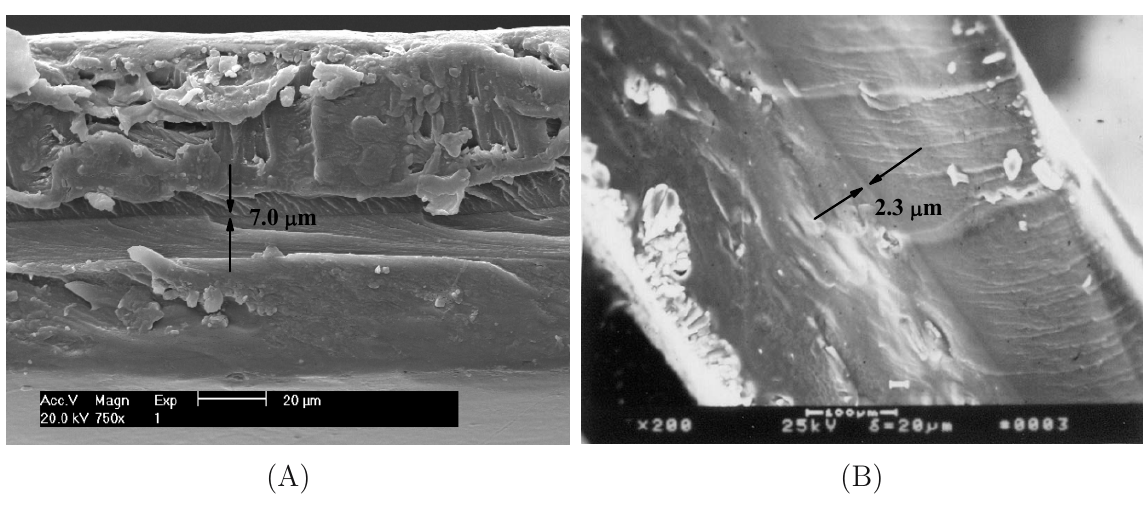
Fig. 3 SEM observation of cross-section view of CMC-CS (A) and SAMS-CMC-CS (B).